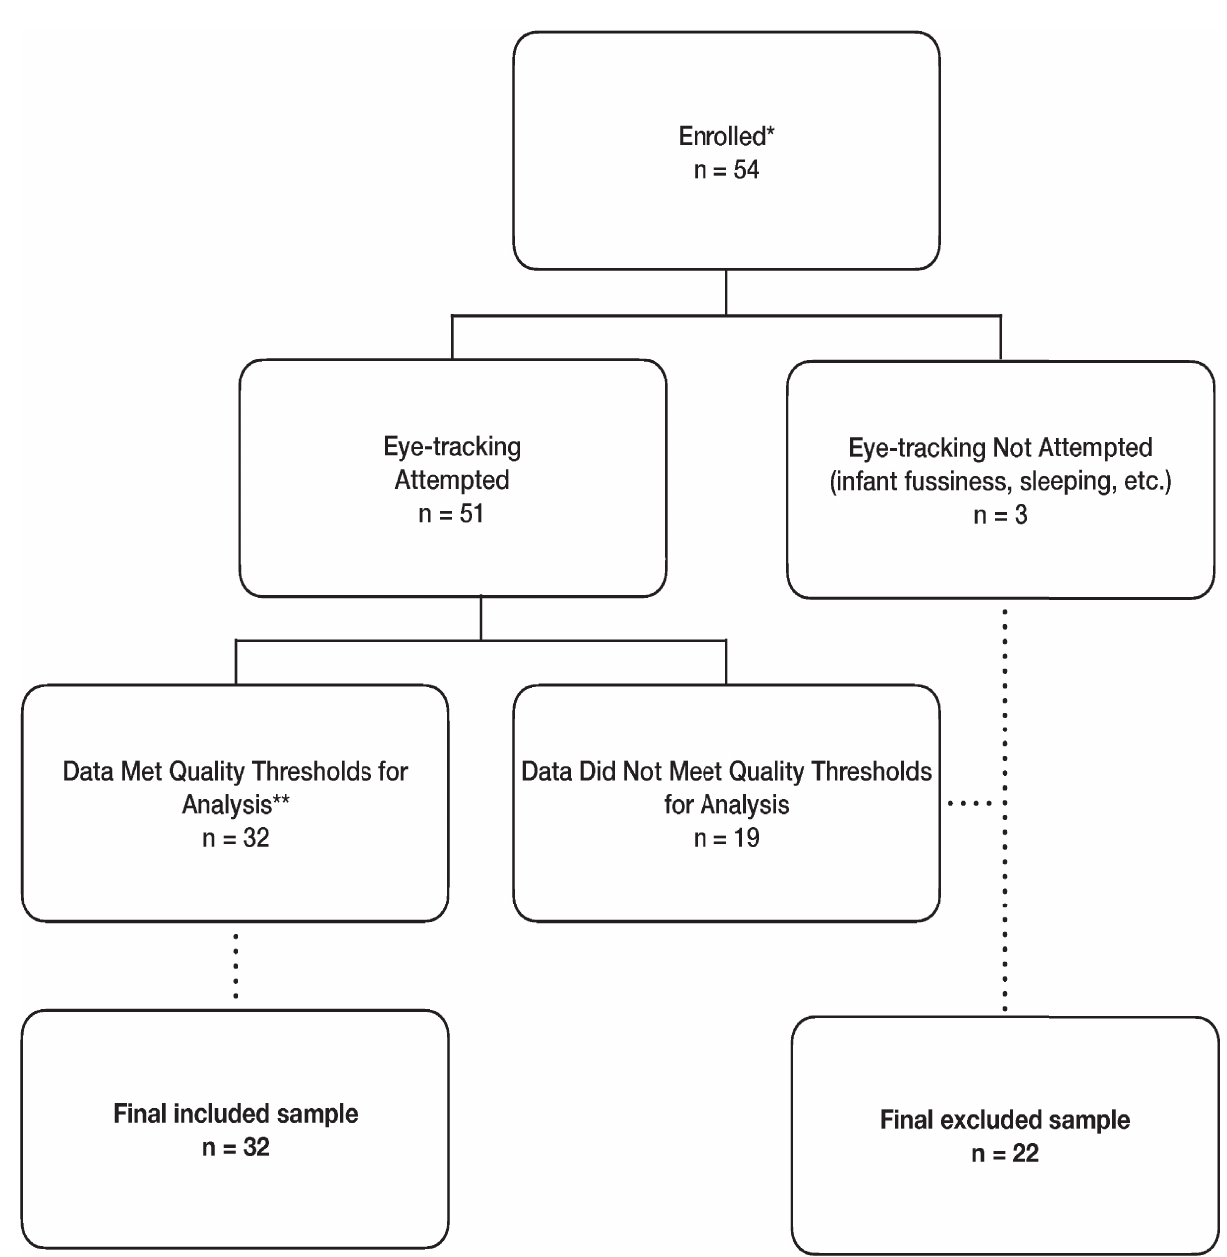
Fig 5. Participant enrollment and data analysis flow chart. A total of 54 mother-infant dyads were enrolled. � An additional 3 dyads were excluded from analysis due to inaccurate pre-enrollment screening. Eye-tracking was not attempted for 3 participants due to infant temperament and difficulty establishing a reliable corneal reflection. For the 51 participants for whom eye-tracking was attempted, data quality metrics are reported. Data from 32 of the 51 participants met or surpassed the 70% threshold for valid data across all 6 trials, and are reported in the analysis of oculomotor dynamics. �� For 2 of the 32 participants whose data met quality thresholds, their data was excluded from analysis of saccade amplitude and saccade velocity due to an error in screen resolution affecting those specific calculations, but was retained for all other analyses of saccade and fixation metrics.